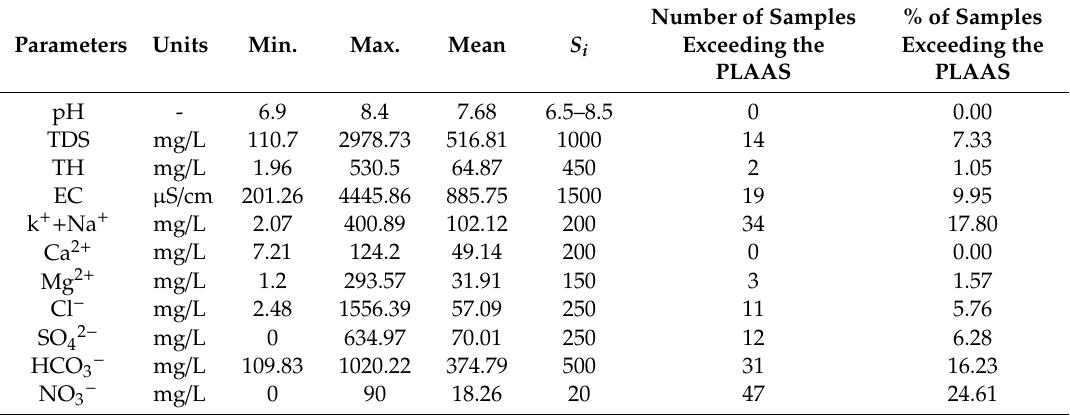
Table 3. Statistical analysis of physiochemical